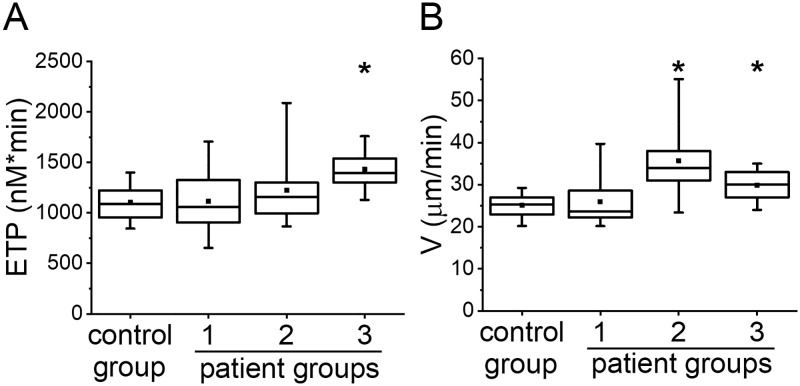
TGT vs TD before heparin treatment.(A) ETP in TGT and (B) V in TD before heparin treatment in groups: healthy volunteers (control group), group 1, group 2) and group 3. The box plots indicate the following parameters: the mean value (the dot inside the box), the median (the horizontal line inside the box), the 25th and 75th percentiles (the bottom and top of the box, respectively) and the 5th and 95th percentiles (the ends of the whiskers). * indicates a significant difference from healthy volunteers group (p<0.01, Mann-Whitney test).